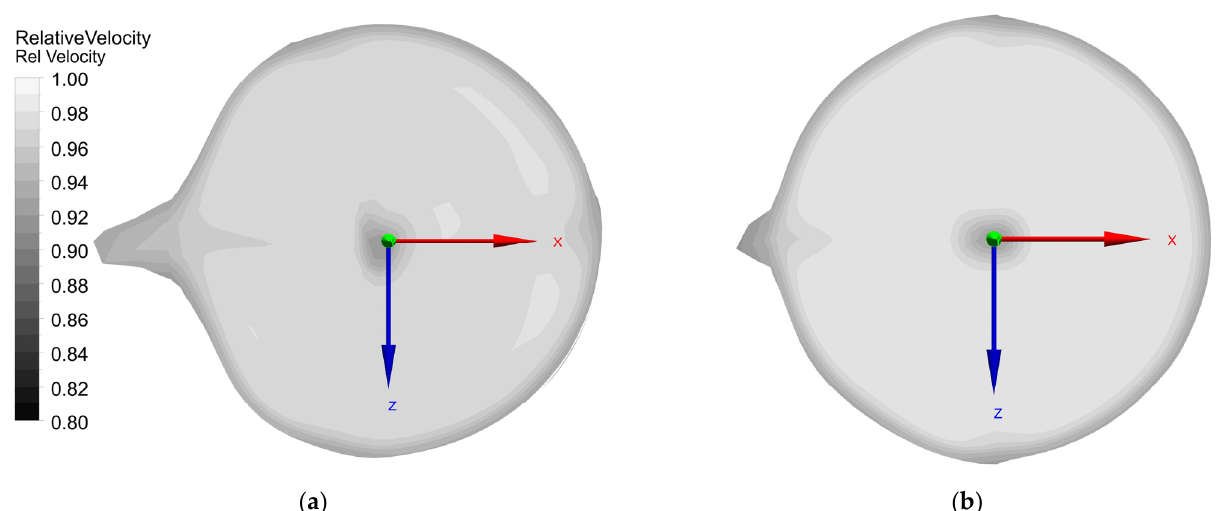
Figure 8. Improvement of the jet cross-section of nozzle 4: ( a ) baseline design; ( b ) design update 2 (both Figures use the same velocity scale).